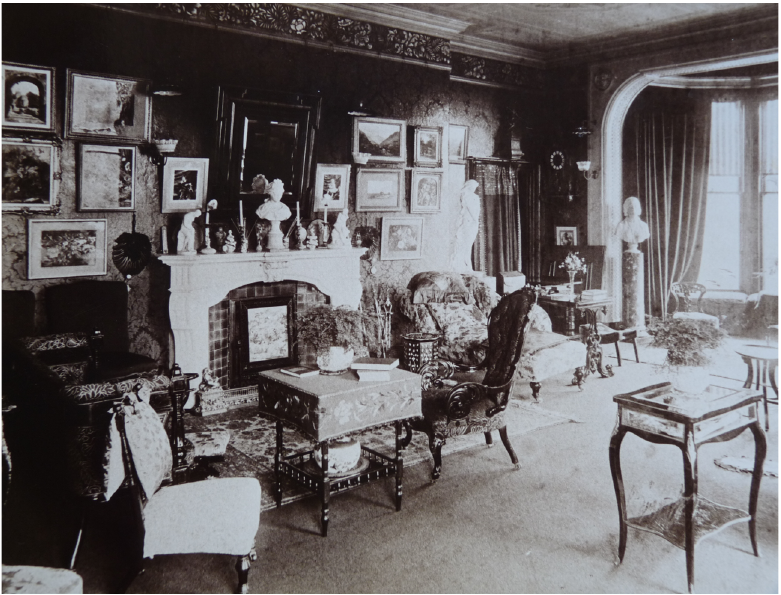
Figure 8: The same drawing room two decades later (Yorkshire Archaeological Society) The expensive Louis-style fireplace is the focal point for both rooms yet so much has changed around it in the Aesthetic scheme that the impact of its carved white marble curves is considerably lessened. The ornate gilded over-mantel mirror has been replaced by a smaller, rectangular-framed mirror: the floral hearth rug which sat upon a fitted floral carpet has been dispensed with in favour of an Oriental rug on plain flooring. Though both rooms contain a lot of furniture, its earlier arrangement feels more formal, even sparser, than is the case in the room of thirty years later. The walls of the Aesthetic room are papered with a large, dark pattern that is topped by a frieze of conventionalised flowers; the ceiling is also decorated, possibly with stencils. Ferns are used as living ornaments to soften the scheme, there are fans hung on either side of the fireplace and by the chaise longue is a Turkish table inlaid with mother-of-pearl, a must- have at this date. Whereas the large chandelier from the mid-century room has gone, plenty of French curves remain in the tables and chairs. Furniture represented one of the biggest investments a couple made when setting up home and one that could not be readily repeated, even by someone as comfortably off as Dr Heaton. This was where fabric and drapery came into its own. In Heaton’s Aesthetic drawing room the deep- buttoned chair has been re-upholstered and the chaise longue covered in cushions. The clutter increased but did it contribute to making a more tasteful